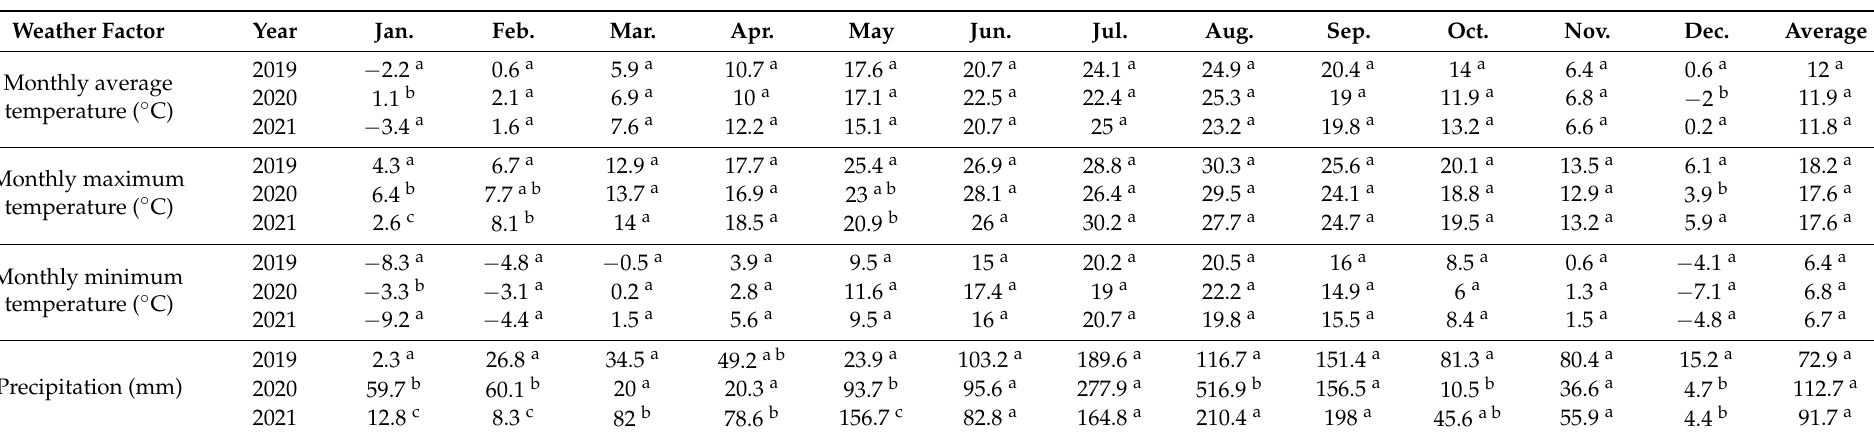
Table 2. Temporal weather data analysis in areas with high spongy moth density in 2019, 2020, and